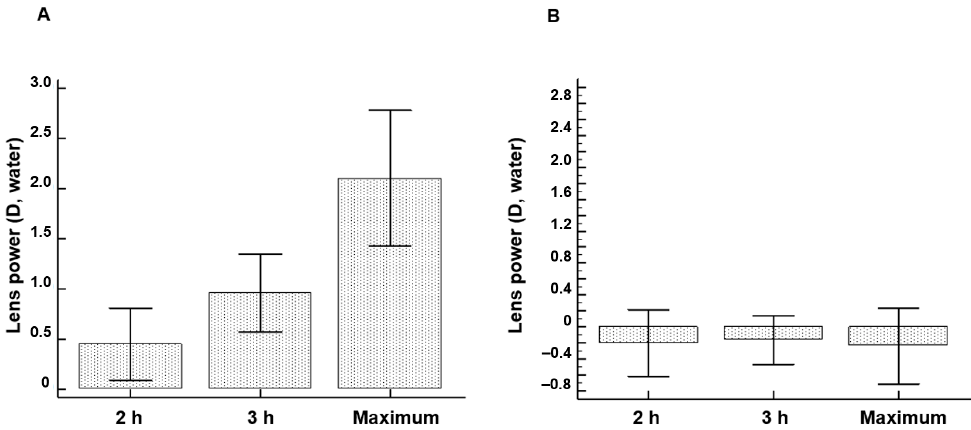
Figure 1. ( A ) E ff ect of topical FAOD treatment on lens power. ( B ) E ff ect of PBS solution on lens